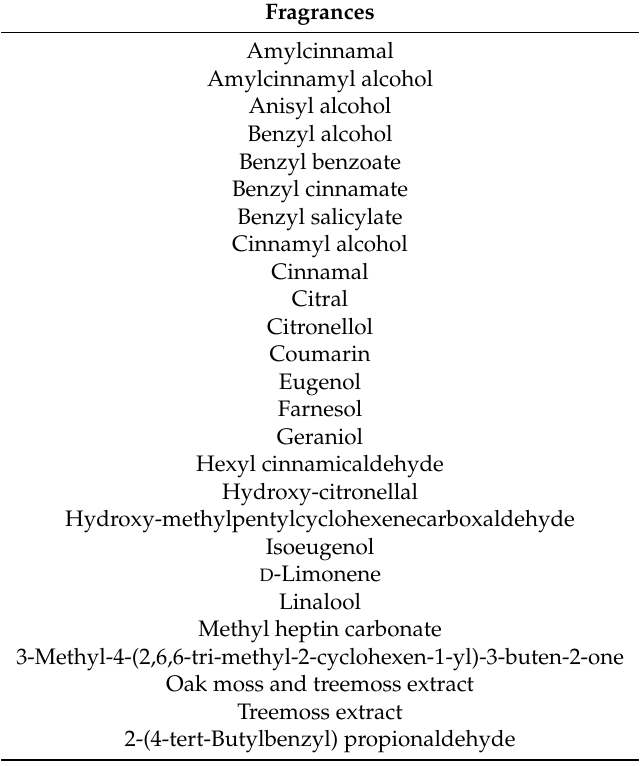
Table 1. List of the 26 allergenic fragrances in accordance with EU Directive.